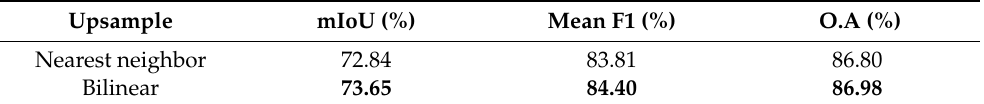
Table 4. The effect of a different upsampling policy in the decoder network using the UDD-6 dataset. Upsample